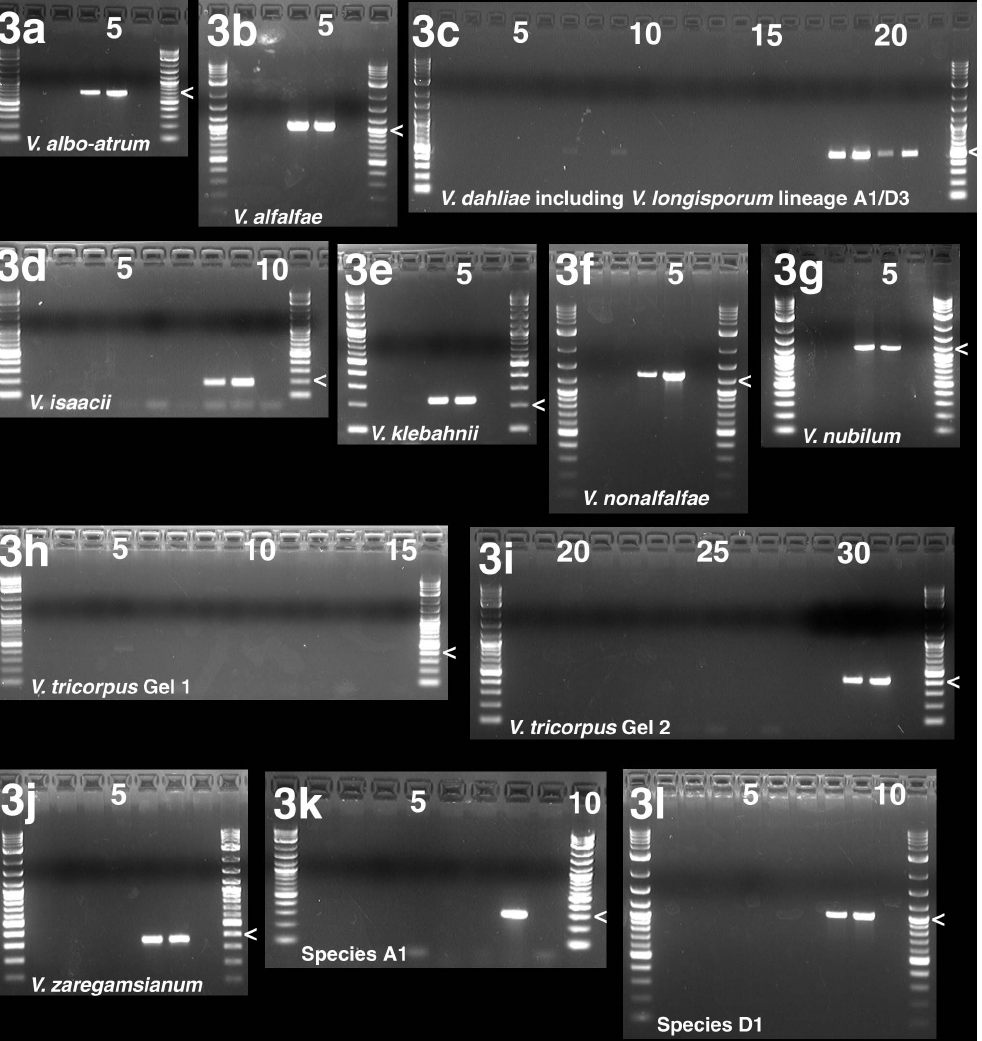
Figure 3. Simplex PCR assays are species-specific except for the V.dahliae simplex PCR assay that also amplifies V.longisporum lineage A1/D3. Agarose gels demonstrating selective amplification of all eleven species-specific simplex PCR assays. Each gel is delimited by 2-log ladders, penultimate lanes are negative controls except in Figure 3h, and relevant size markers are indicated by ‘ , ’. Lanes are numbered from left to right; numbers are given by the lanes for every fifth lane. The PCR assay target species are indicated at the bottom of gels. For explanation of isolates selected as negative controls see text. 3a. Verticillium albo-atrum PCR assay. Lanes 2, 3: V. nubilum strain PD621, 10 and 100 ng of DNA, respectively. Lanes 4, 5: V. albo-atrum strain PD693, 10 and 100 ng of DNA, respectively. Size marker=700 bp. 3b. Verticillium alfalfae PCR assay. Lanes 2, 3: V. nonalfalfae strain PD592, 10 and 100 ng DNA. Lanes 4, 5: V. alfalfae strain PD683, 10 and 100 ng DNA. Size marker=1000 bp. 3c. Verticillium dahliae PCR assay. Lanes 2, 3: V. albo-atrum strain PD670, 10 and 100 ng DNA. Lanes 4, 5: V. alfalfae strain PD338, 10 and 100 ng DNA. Lanes 6, 7: V. klebahnii strain PD347, 10 and 100 ng DNA. Lanes 8, 9: V. nonalfalfae strain PD592, 10 and 100 ng DNA. Lanes 10, 11: V. nubilum strain PD621, 10 and 100 ng DNA. Lanes 12, 13: V. tricorpus strain PD593, 10 and 100 ng DNA. Lanes 14, 15: V. zaregamsianum strain PD586, 10 and 100 ng DNA. Lanes 16, 17: V. isaacii strain PD341, 10 and 100 ng DNA. Lanes 18, 19: V. dahliae strain PD323, 10 and 100 ng DNA. Lanes 20, 21: V. longisporum lineage A1/D3 strain PD589, 10 and 100 ng DNA. Size marker=500 bp. Note that the V. dahliae assay also amplifies V. longisporum lineage A1/D3, see lanes 20 and 21. 3d. Verticillium isaacii PCR assay. Lanes 2, 3: V. klebahnii strain PD347, 10 and 100 ng DNA. Lanes 4, 5: V. klebahnii strain PD407, 10 and 100 ng DNA. Lanes 6, 7: V. tricorpus strain PD593, 10 and 100 ng DNA. Lanes 8, 9: V. isaacii strain PD341, 10 and 100 ng DNA. Size marker=200 bp. 3e. Verticillium klebahnii PCR assay. Lanes 2, 3: V. isaacii strain PD341, 10 and 100 ng DNA. Lanes 4, 5: V. klebahnii strain PD347, 10 and 100 ng DNA. Size marker=200 bp. 3f. Verticillium nonalfalfae PCR assay. Lanes 2, 3: V. alfalfae strain PD683, 10 and 100 ng DNA. Lanes 4, 5: V. nonalfalfae strain PD592, 10 and 100 ng DNA. Size marker=1200 bp. 3g. Verticillium nubilum PCR assay. Lanes 2, 3: V. nonalfalfae strain PD592, 10 and 100 ng DNA. Lanes 4, 5: V. nubilum strain PD741, 10 and 100 ng DNA. Size marker=1200 bp. 3h, 3i. Verticillium tricorpus PCR assay. Lanes 2, 3: V. dahliae strain PD322, 10 and 100 ng DNA. Lanes 4, 5: V. longisporum lineage A1/D1 strain PD591, 10 and 100 ng DNA. Lanes 6, 7: V. longisporum lineage A1/D2 strain PD356, 10 and 100 ng DNA. Lanes 8, 9: V. alfalfae strain PD338, 10 and 100 ng DNA. Lanes 10, 11: V. nonalfalfae strain PD592, 10 and 100 ng DNA. Lanes 12, 13: V. nubilum strain PD621, 10 and 100 ng DNA. Lanes 14, 15: V. albo-atrum strain PD670, 10 and 100 ng DNA. Lanes 18, 19: V. albo-atrum strain PD693, 10 and 100 ng DNA. Lanes 20, 21: V. zaregamsianum strain PD586, 10 and 100 ng DNA. Lanes 22, 23: V. zaregamsianum strain PD739, 10 and 100 ng DNA. Lanes 24, 25: V. isaacii strain PD341, 10 and 100 ng DNA. Lanes 26, 27: V. klebahnii strain PD347, 10 and 100 ng DNA. Lanes 28, 29: Gibellulopsis nigrescens strain PD595, 10 and 100 ng DNA. Lanes 30, 31: V. tricorpus strain PD685, 10 and 100 ng DNA. Size marker=400 bp. 3j. Verticillium zaregamsianum PCR assay. Lanes 2, 3: V. tricorpus strain PD685, 10 and 100 ng DNA. Lanes 4, 5: V. tricorpus strain PD703, 10 and 100 ng DNA. Lanes 6, 7: V. zaregamsianum strain PD586, 10 and 100 ng DNA. Size marker=400 bp. 3k. Species A1 PCR assay. Lanes 2, 3: V. dahliae strain PD323, 10 and